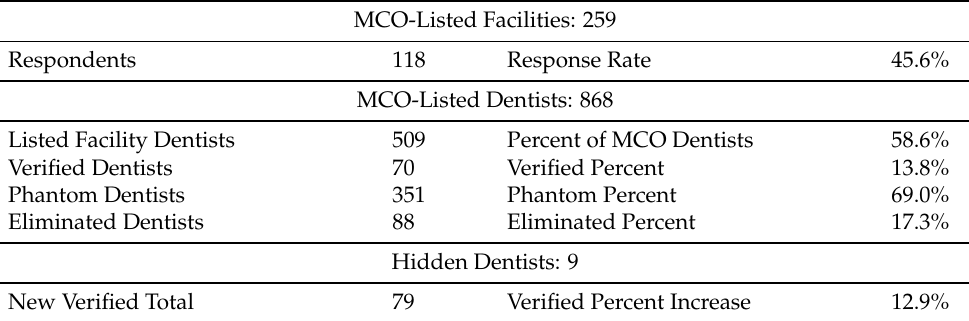
Table 2. Survey responses of facilities and dentists in MCO